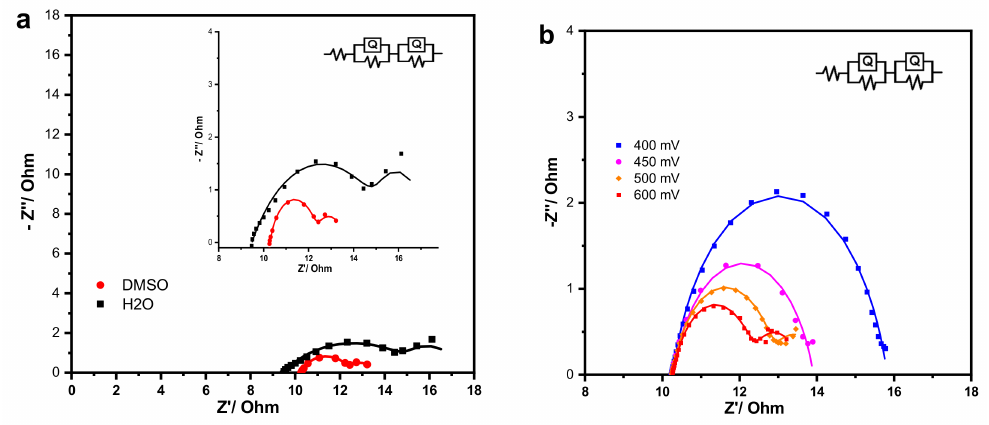
Figure 9. ( a ) Nyquist plots of the Ni(OH) 2 /CP electrodes, the inset plot displays the equivalent circuit model; ( b ) and its corresponding Nyquist plot obtained for the Ni(OH) 2 -DMSO/CP electrode logged at various voltages in 1.0 M KOH containing 0.33 M